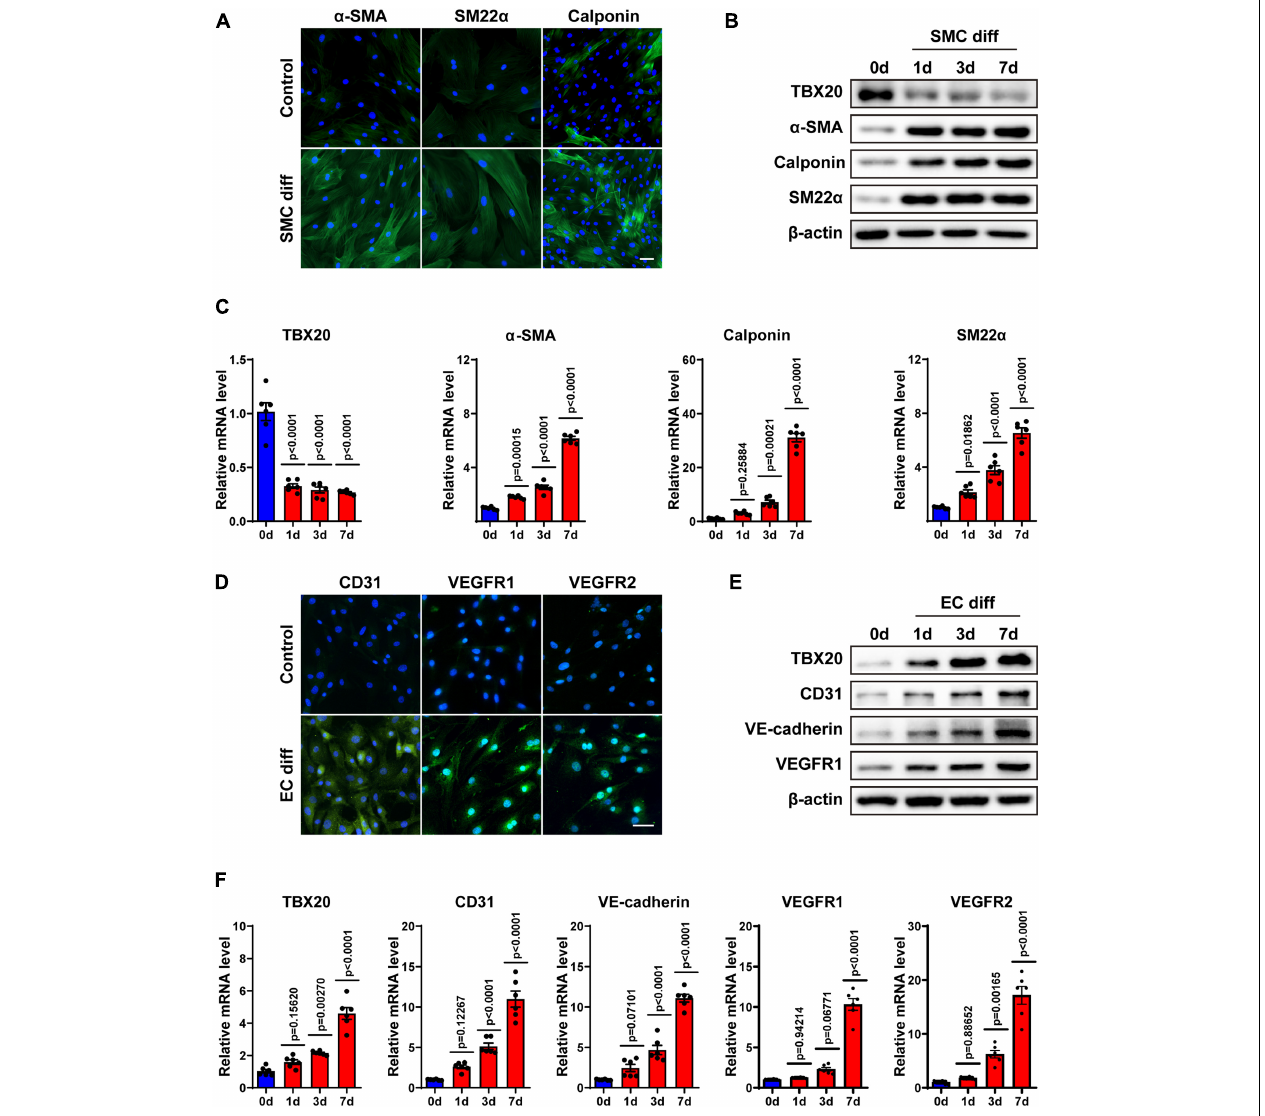
FIGURE 2 | TBX20 may play a role in the differentiation of PVASCs to SMCs and ECs. (A) PVASCs were treated with or without TGF- β 1 (5 ng/mL) for 7 days. Immunofluorescent staining showed the upregulation of SMC markers. (B,C) PVASCs were cultured in SMC differentiation medium for 0, 1, 3, and 7 days. Western Blot analysis and QPCR analysis of TBX20, α -SMA, SM22 α , and calponin. (D) PVASCs were cultured in the control medium or EGM-2 medium for 7 days. Immunofluorescent staining of EC markers showed upregulation in differentiated PVASCs toward endothelial cells. (E,F) PVASCs were cultured in the EGM-2 medium for 0, 1, 3, and 7 days. Western Blot analysis and QPCR analysis of TBX20, CD31, VE-cadherin, VEGFR1, and VEGFR2. Scale bar = 100 µ m. Cell nuclei were stained with DAPI.